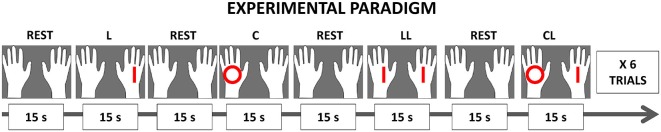
Experimental paradigm. The timeline of the study was an alternation of experimental blocks and of rest blocks with the same duration (15 s). A total of 24 experimental blocks (6 repetitions for each of the 4 experimental conditions) was presented to each patient. The study started and ended with a longer rest period (30 s). During the experimental condition blocks, patients had to perform hand movements following the visual cues appearing on the screen within two white hands. Whereas during the rest blocks, patients had to attend the picture depicting two white hands. The possible combination of the observed stimuli matched the experimental conditions: unimanual Lines with the right hand (L); unimanual Circles with the left hand (C); bimanual congruent Lines-Lines (LL), simultaneously with both hands (LL); bimanual non-congruent Circles-Lines (CL), simultaneously with the right hand drawing Lines and the left hand drawing Circles (CL).